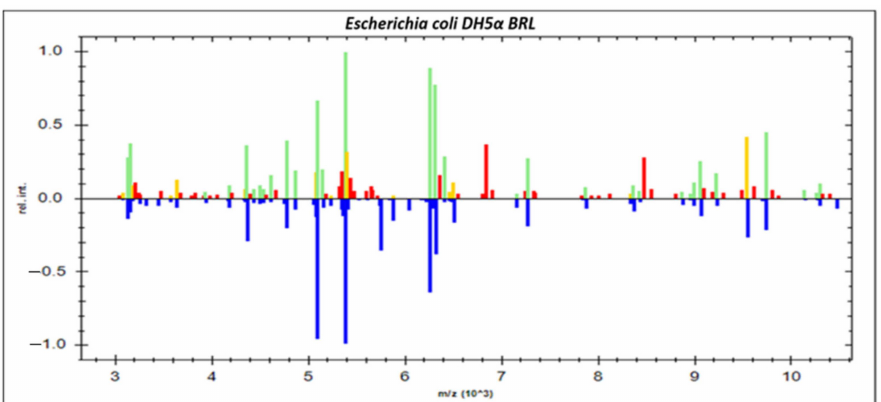
Figure 2. Comparison of the spectral protein profiles of 43 Escherichia coli strains recovered from chilled ground meat samples with those of Escherichia coli DH5 α as a reference strain using Compass Satellite